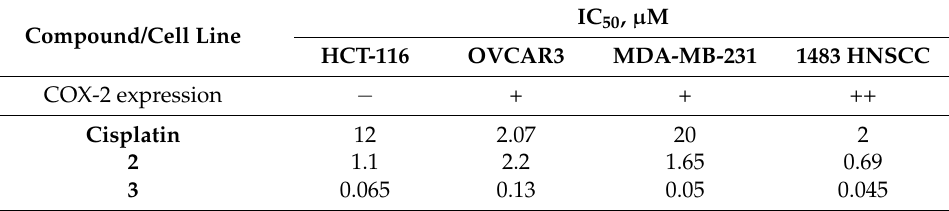
Table 3. Antiproliferative activity of cisplatin and platinum(IV) prodrugs 2 and 3 on HCT-116 (colorectal carcinoma), OVCAR3 (ovarian cancer), MDA-MB-231 (triple negative breast cancer), and 1483 HNSCC (head and neck squamous cell carcinoma) cell lines. The ability of cells to express cyclooxygenase-2 (COX-2) is indicated by “ − ” (non-expressing), “+” (expressing), “++” (strongly expressing).